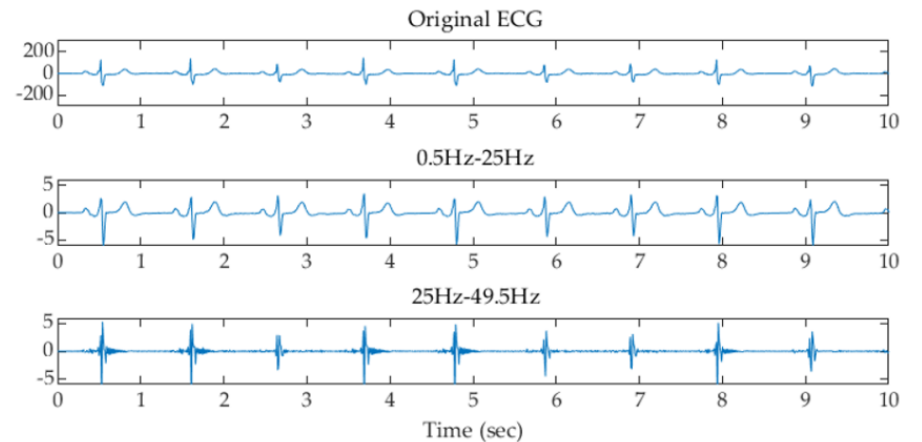
Figure 3. Examples of the original ECG and the signals after filtering using the filter bank with 2 Butterworth filters and z-score normalization.